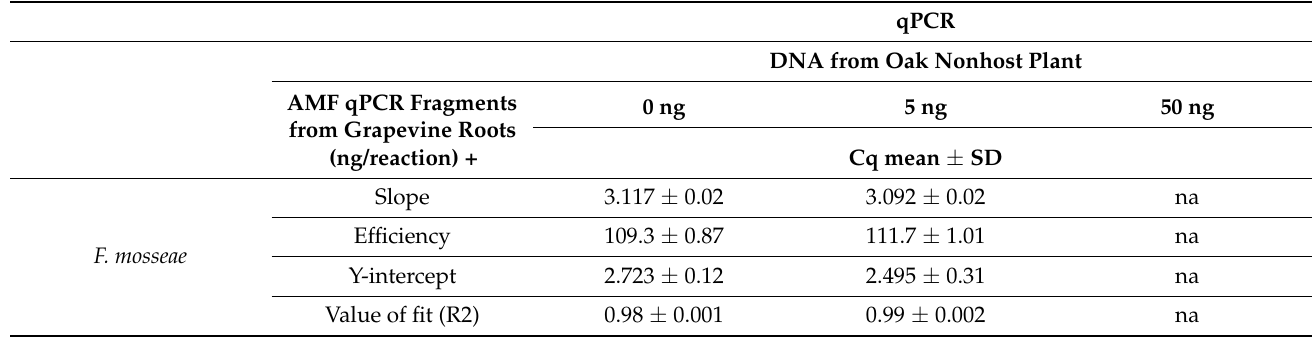
Figure 1. AMF mycelium colonization (M%), ( a ), and arbuscular abundance (A%) ( b ), detected by non-vital staining from each asymptomatic and contiguous esca symptomatic plants from each site (S) individuate in the vineyards (Vyn_1, Vyn_2 and Vyn_3). Positive correlation among esca symptomatic and asymptomatic plants of both AMF mycelium colonization (Figure 2a) and arbuscular abundance was detected (Figure 2b).